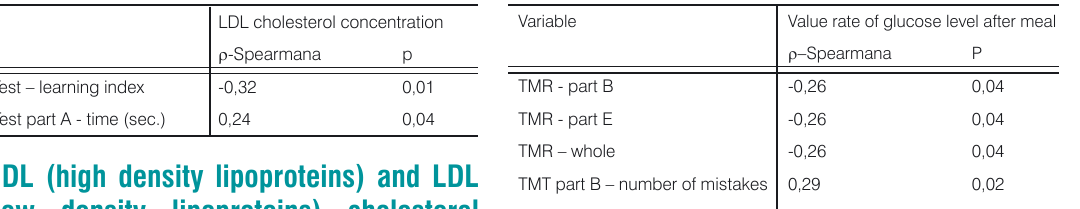
Table 3. The ρ -Spearman’s correlation coefficient for value rate of glucose level after meal and cognitive